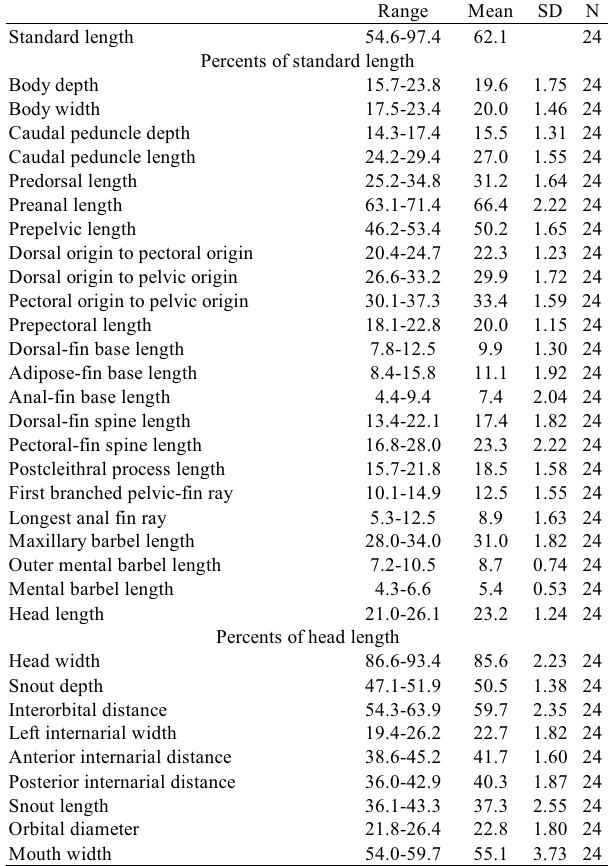
Table 4. Morphometric data for Tatia brunnea . SD = standard